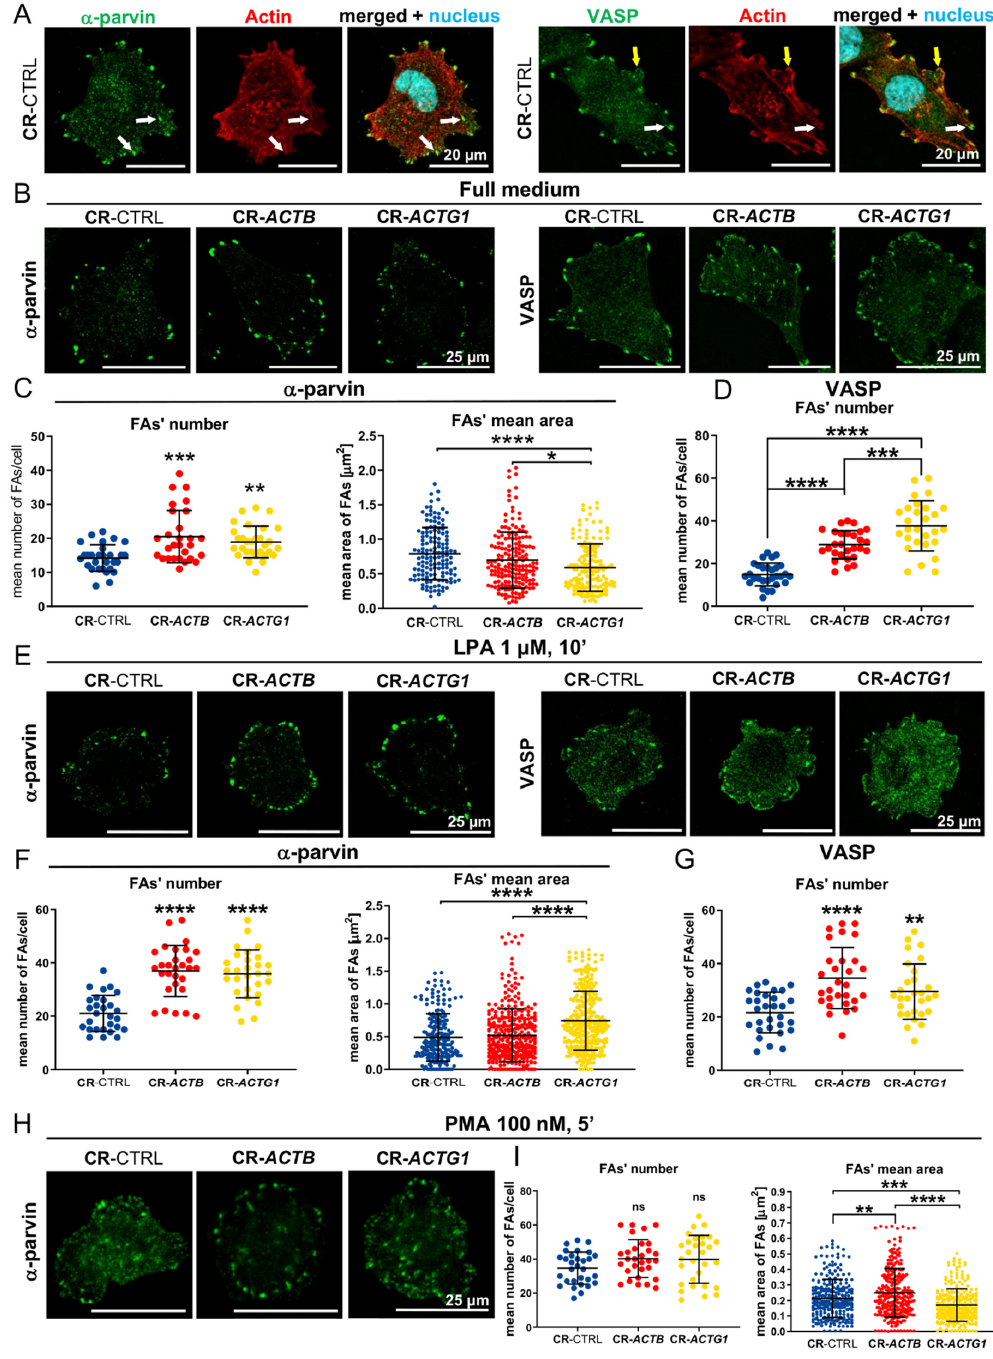
Figure 7. Focal adhesion formation is altered in clones devoid of β or γ actin. ( A ) Immunostaining detecting α -parvin, VASP, and total actin. The genetically nonmanipulated A375 cells were grown under full medium conditions. White arrows point at focal adhesions, while yellows ones at nascent focal adhesions (FAs) / accumulation of VASP. ( B , E , H ) The clones growing either in full medium or incubated with LPA or PMA were fixed and stained with antibodies recognizing α -parvin or VASP. ( C , F , I ) The number of α -parvin-rich focal adhesions as well as their surface area were calculated for every tested condition ( n = 30). ( D , G ) The number of VASP-rich focal adhesions was calculated ( n = 30). Results are expressed as the mean ± SD, p ≤ 0.05 (*), p ≤ 0.01 (**), p ≤ 0.001 (***), p ≤ 0.0001